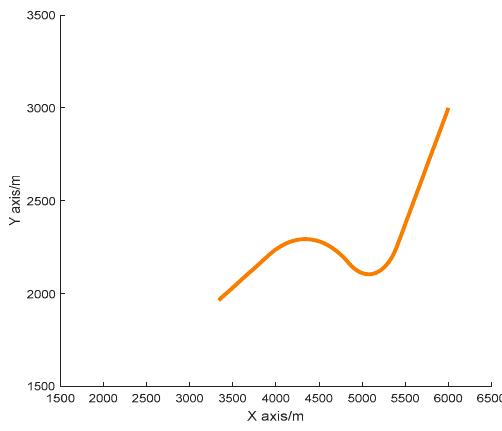
Figure 4. The true trajectory of the single target.